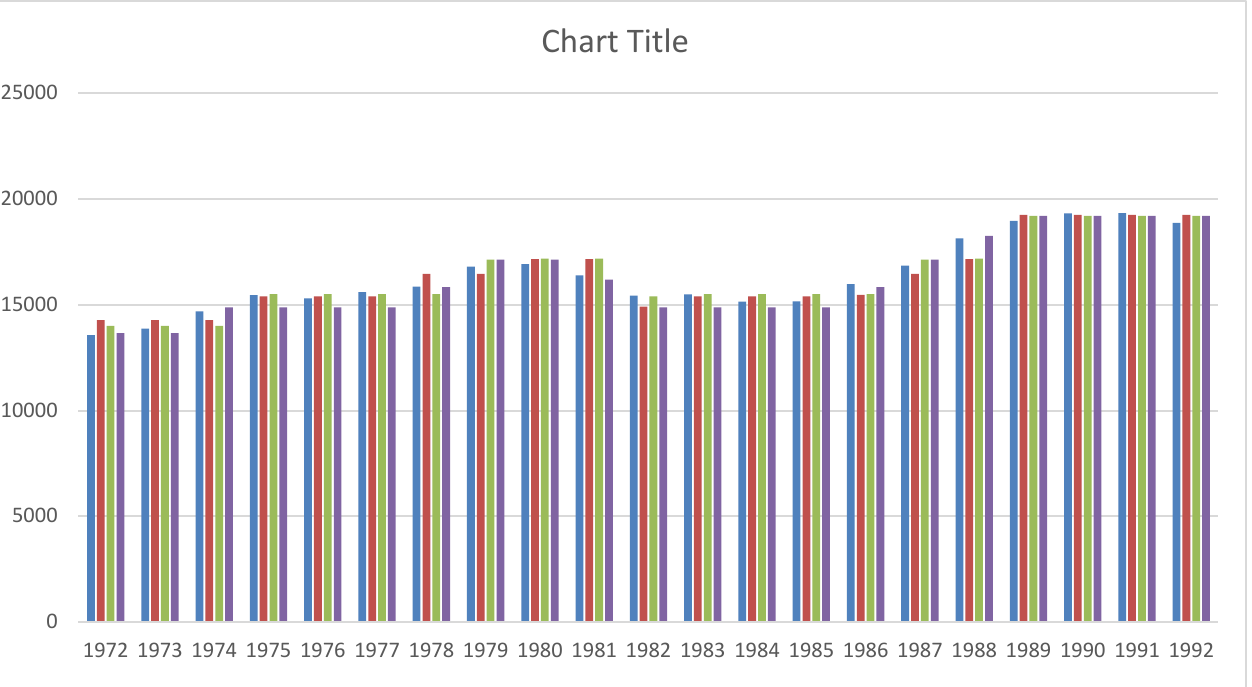
Figure 3. Chart illustrates Table